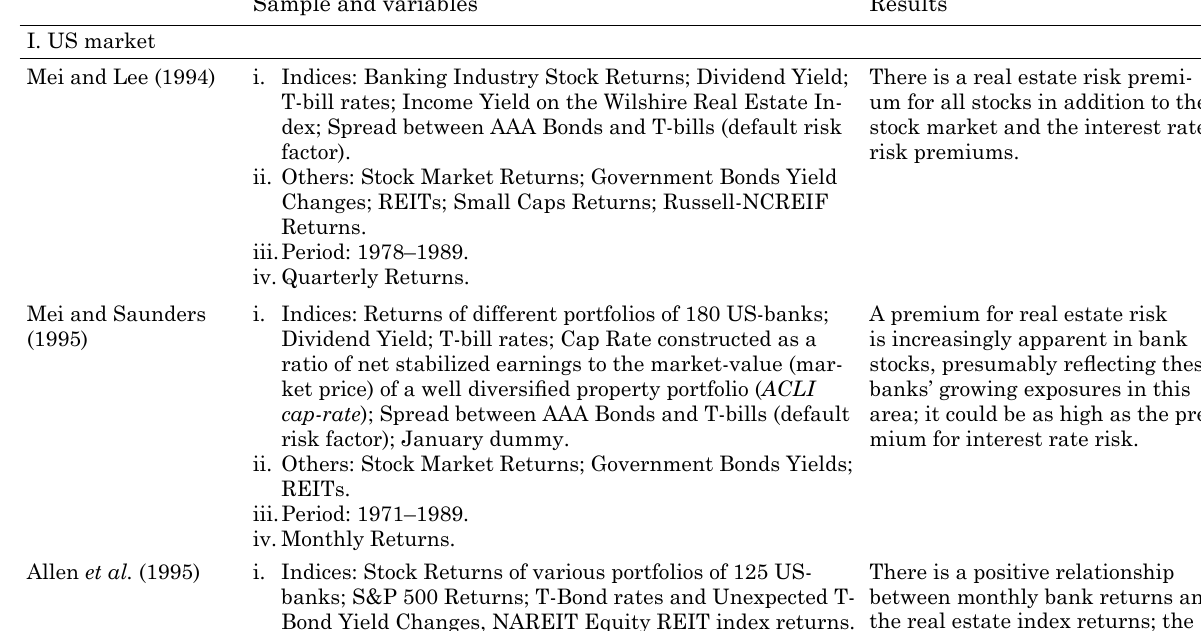
Table 1. Empirical studies on the relationship between market capitalization of banks and the real estate market Sample and